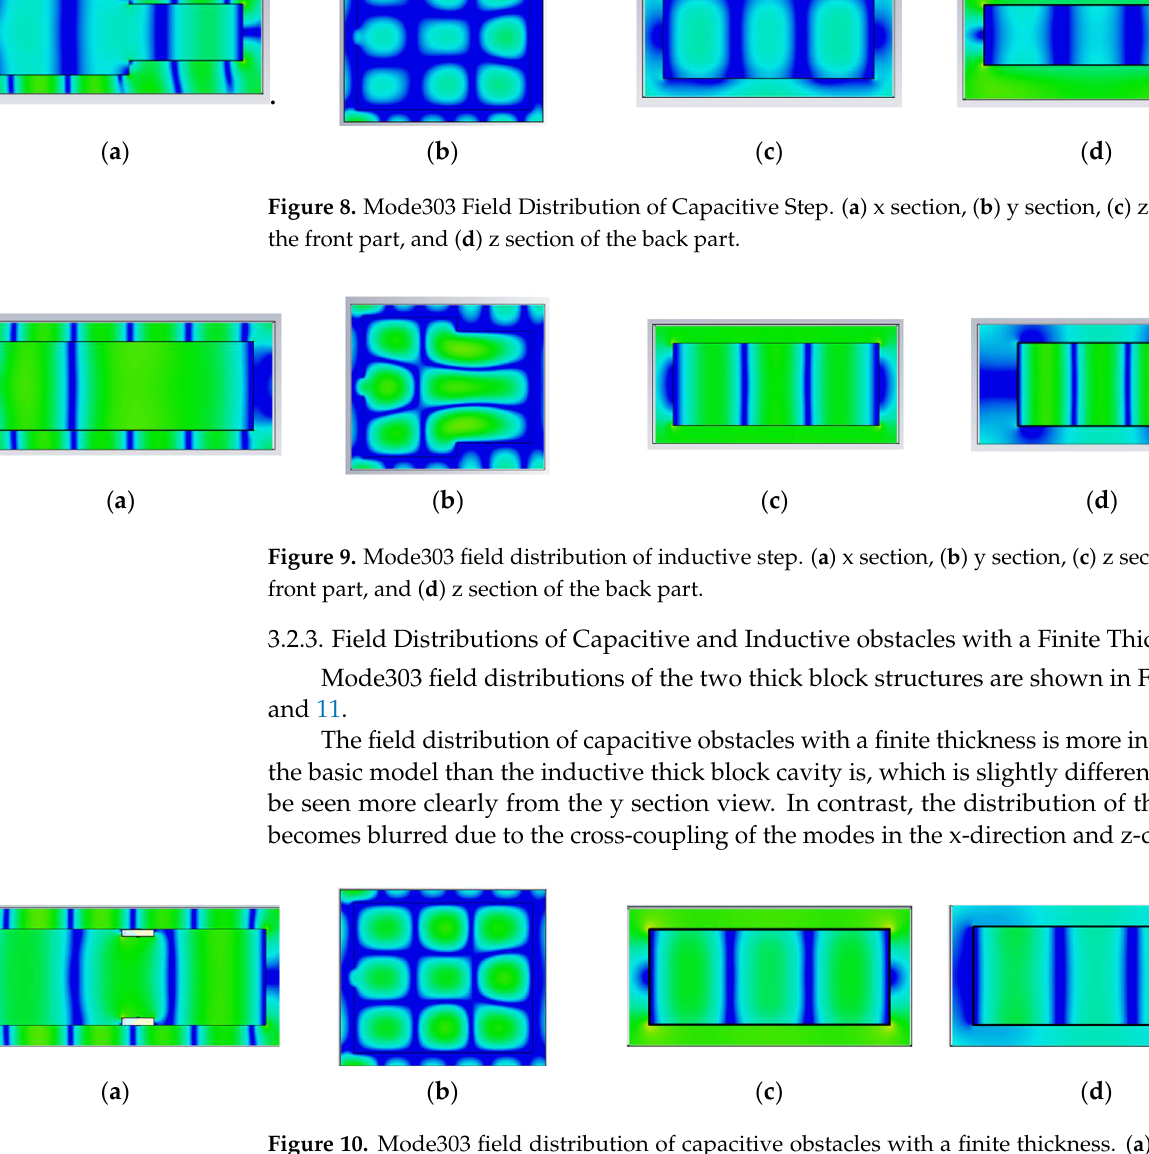
( d ) Figure 11. Mode303 field distribution of inductive obstacles with a finite thickness. ( a ) x section, ( b ) y section, ( c ) z section of the front part, and ( d ) z section of the back part. 3.2.4. Field Distributions of Capacitive and Inductive Obstacles with Zero Thickness